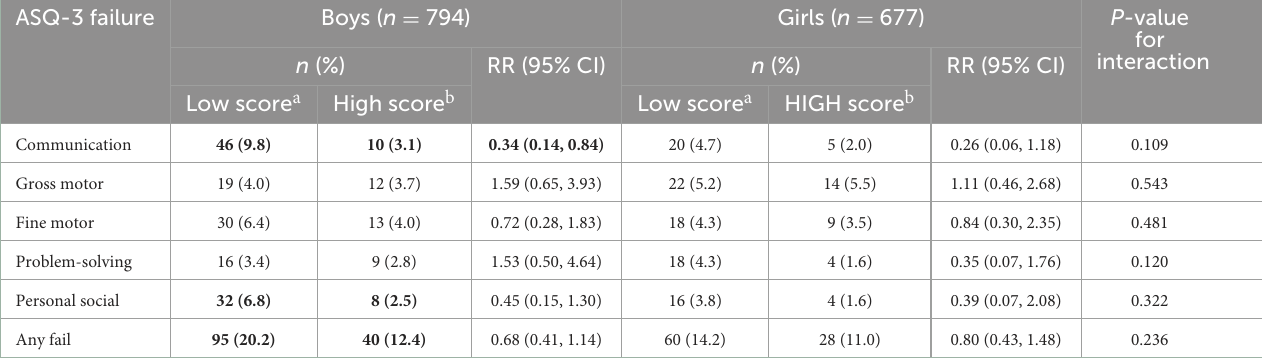
TABLE 3 Gender-specific effects on the relationship of Mediterranean diet score (4–7 vs. 0–3) with ASQ-3